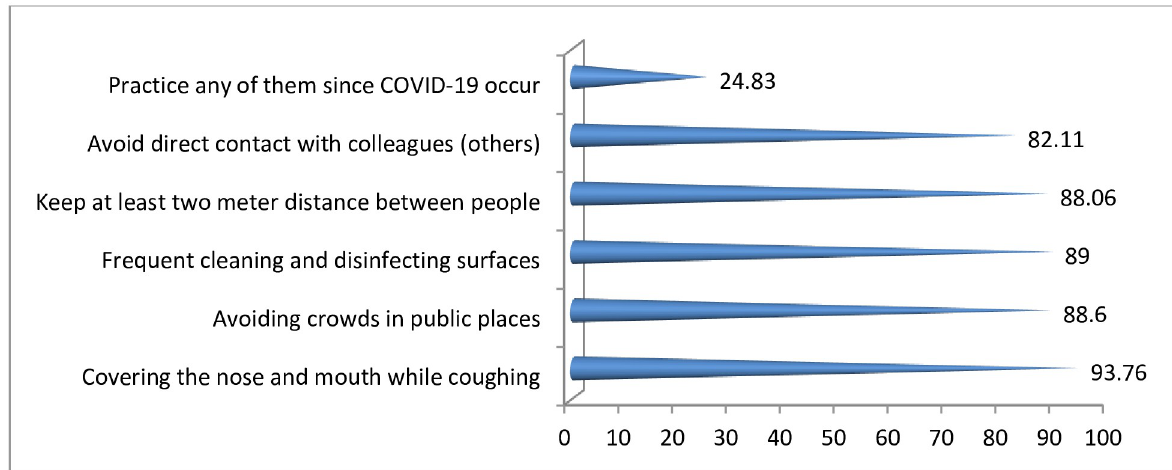
Fig 10. Percentage of measures taken by respondents, Oromia region, Ethiopia, September 2020 to March 2021. NB: Percentage may not add 100% as multiple responses were possible.